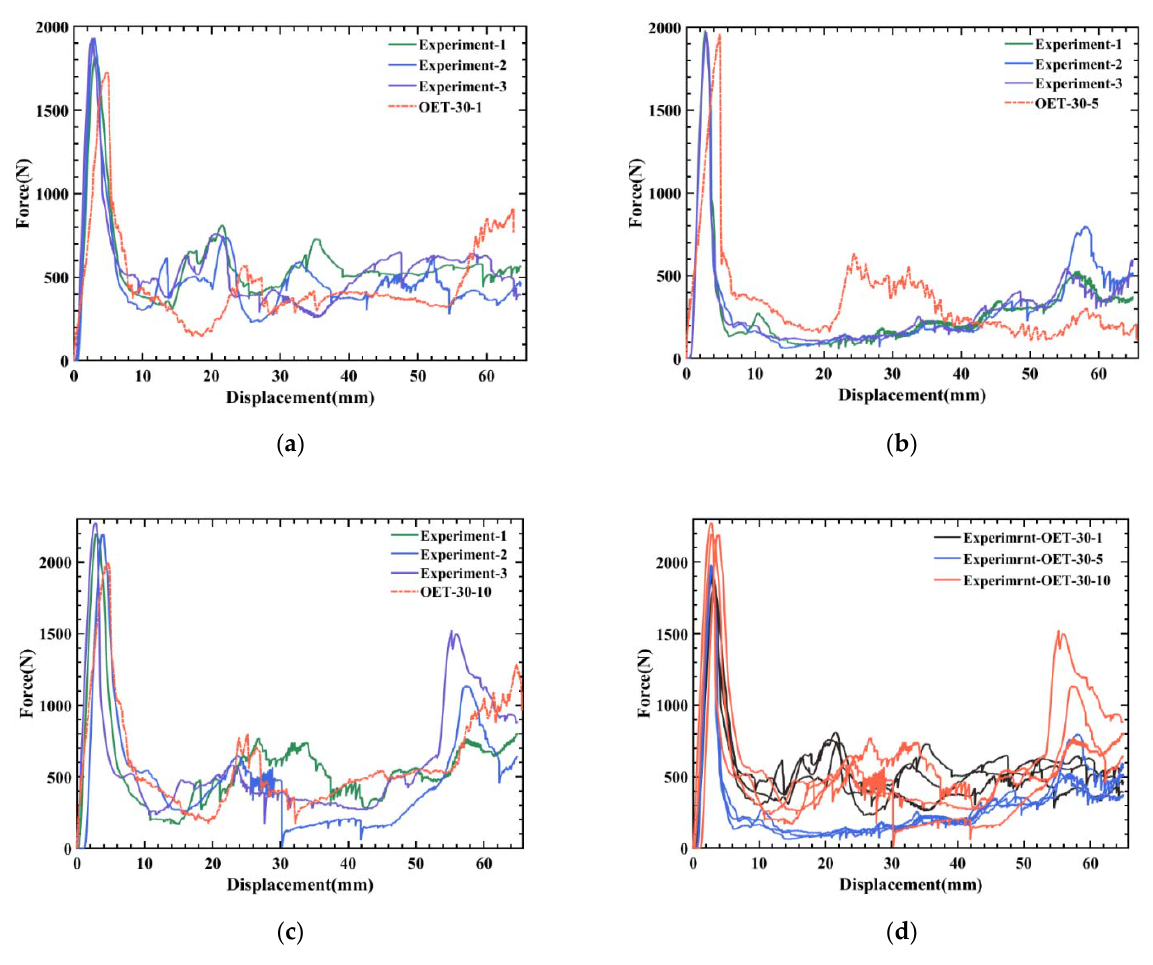
Figure 5. Force–displacement curves of OET loading rate at 30 °C: ( a – c ) are the comparison between experiment and simulation when the compression rate at 1 mm/min, 5 mm/min, and 10 mm/min, respectively. ( d ) Comparison of different loading rates. Table 3. Data comparison between the experimental and simulation results of